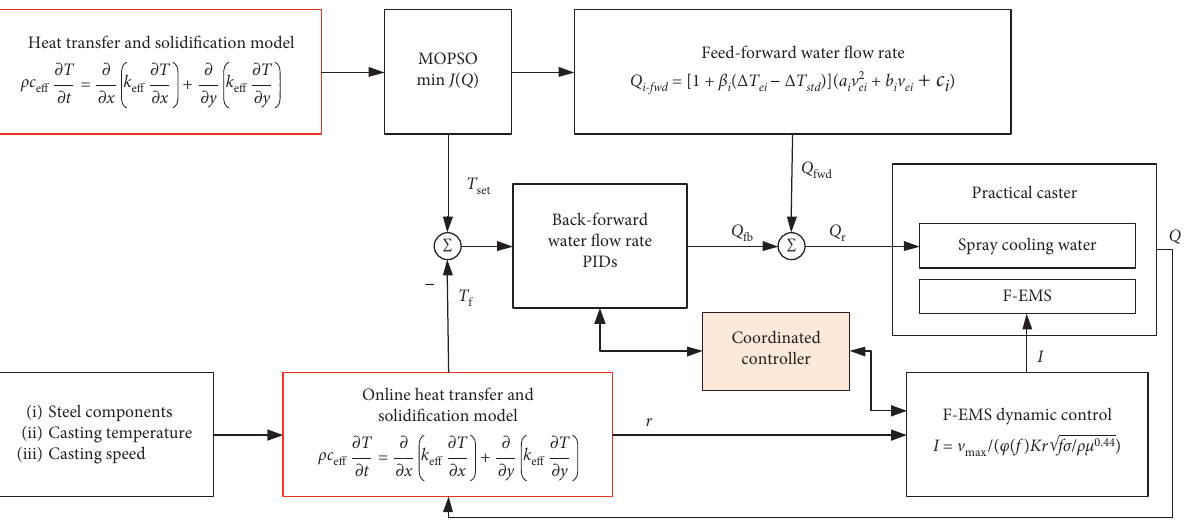
Figure 2: Framework of the optimal control